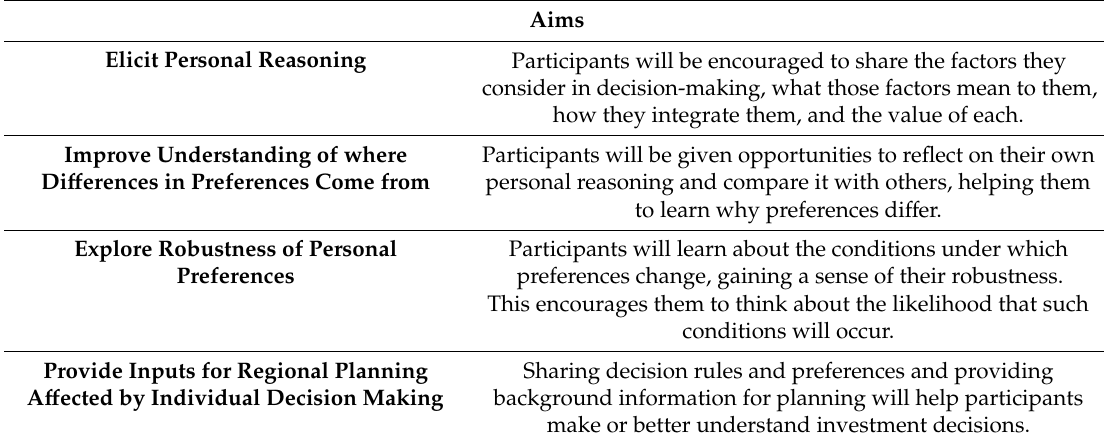
Table 1. Participatory crossover analysis is considered suitable to achieve one or more of the following aims.